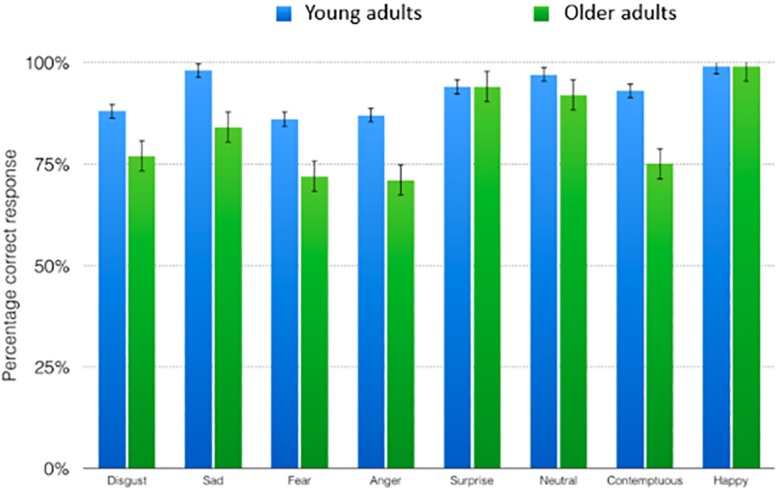
The percentage correct responses for all emotion labels in the function of age group.